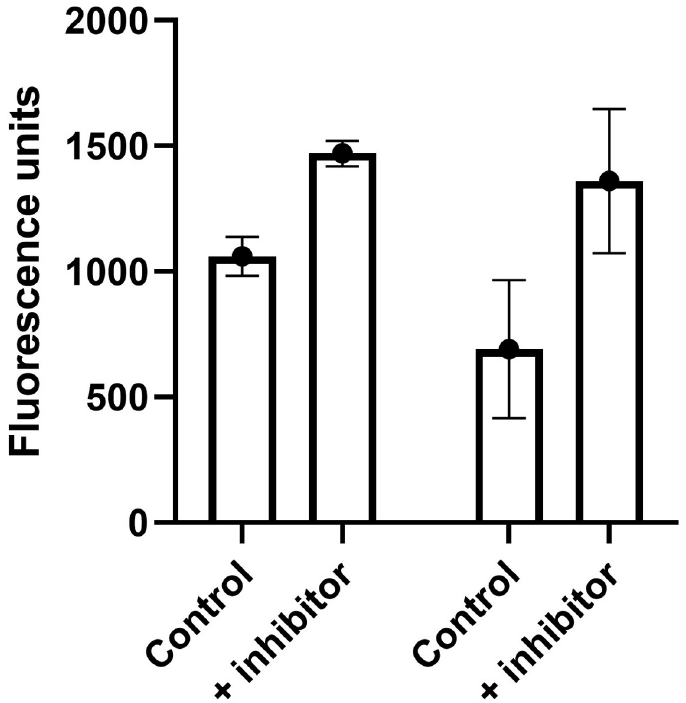
Fig 6. Activity of ABCB1 measured with Rho-123, comparing transfer across hydrogel cultures at 6hrs, in the absence or presence of the inhibitor zosuquidar. Mean ± SEM, n = 4, P = 0.0024 by one way t-test. Activity of ABCG2 measured with mitoxantrone, comparing transport at 24hrs across cells on filters, in the absence or presence of its inhibitor Ko143. Mean ± SEM, n = 6, P = 0.062.